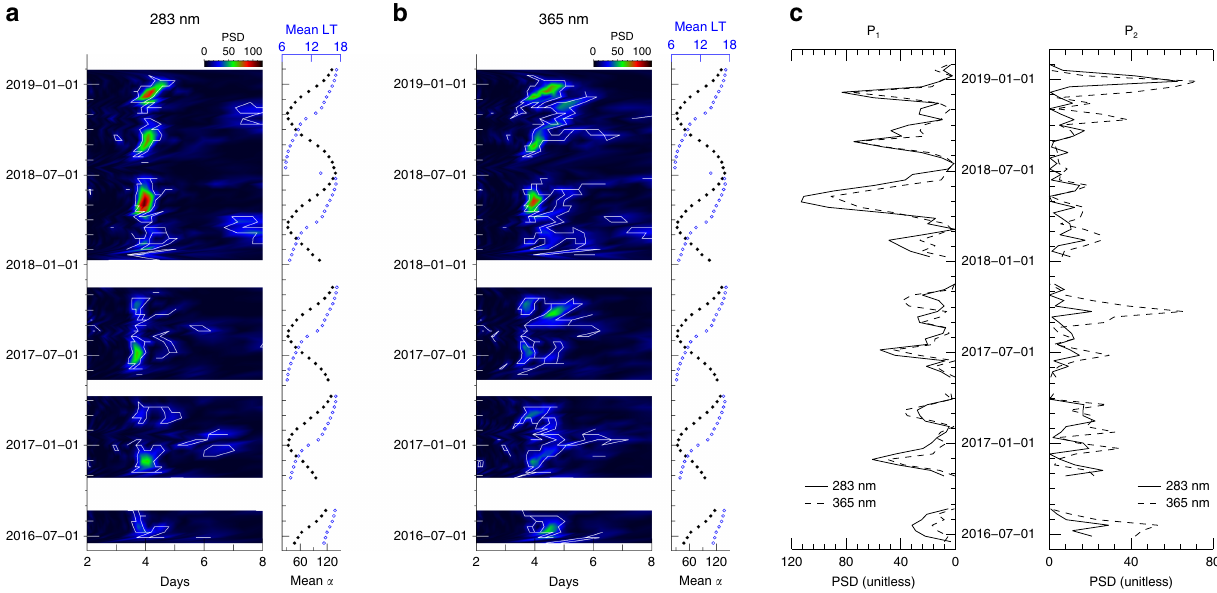
Fig. 4 Long-term evolution of the periodograms at (a) 283 nm and (b) 365 nm. The periodograms are calculated over 33-day windows (3 × Akatsuki ’ s orbital period), which are sequentially shifted in steps of 11 days. Mean phase angle ( α , in degree) and mean local time (LT, in hours) are marked on the right-hand sides of ( a ) ( b ). The power spectral density (PSD) is shown in colors. The white solid line indicates the 99% signi fi cant level. c Comparison of PSD cross-sections at P 1 (3.9 days) and P 2 (4.6 days) (corresponding to the detected peaks in Supplementary Fig. 7) for both